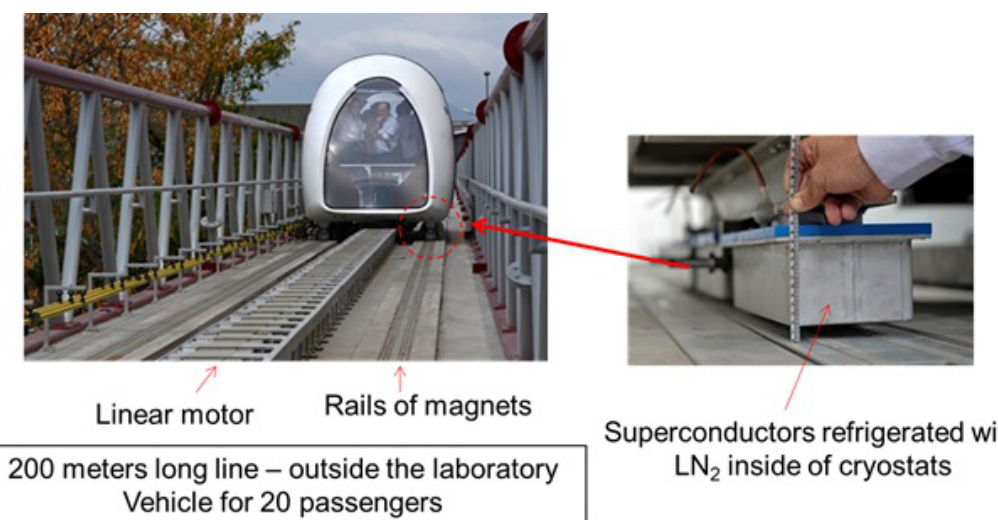
Figure 3. Graphic abstract of the MagLev 2 -Cobra project.